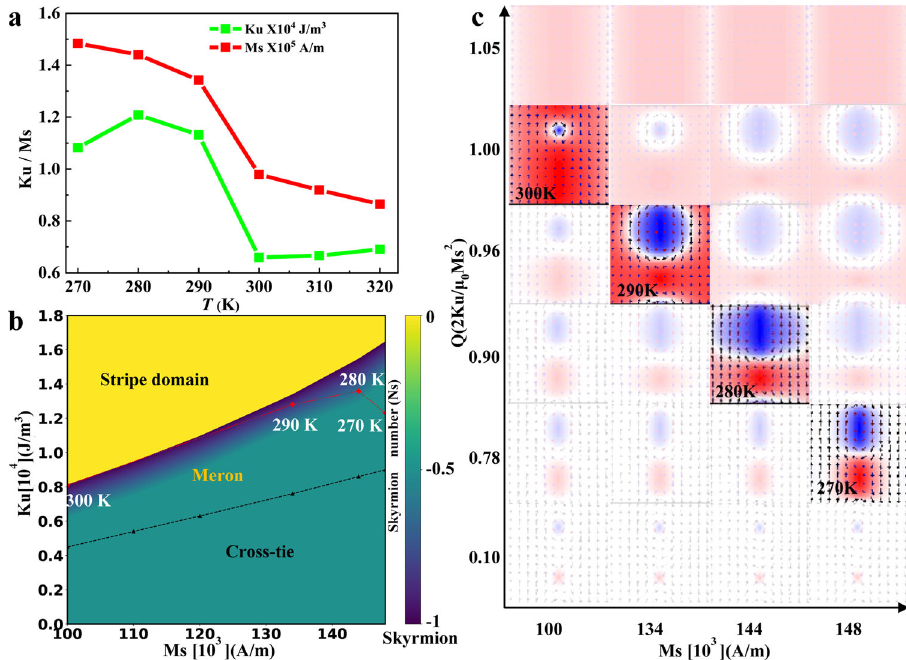
Fig. 3 The magnetization and domain evolution based on experiments and simulations in Gd 15 + x (Fe 94 Co 6 ) 85 − x ( x = 0.2). a The dependence of magnetic parameters on temperature extracted from experimental results. b The domain phase diagram in terms of varying M s and K u for a fi xed A = 7×10 − 12 J/m with experimental data points marked in red. Color map represents the skyrmion number and delineates the boundary between different magnetic phase regions, indicating the continuous transformation between meron pair and skyrmions but the abrupt transition from skyrmion to stripe domains. c The simulated magnetization states for different parameters. The highlight images re fl ect the experimental transformation at different temperatures. The out-of-plane magnetization is represented by regions in red ( + m z ) and blue ( − m z ), whereas the in-plane magnetization is represented by white regions with black